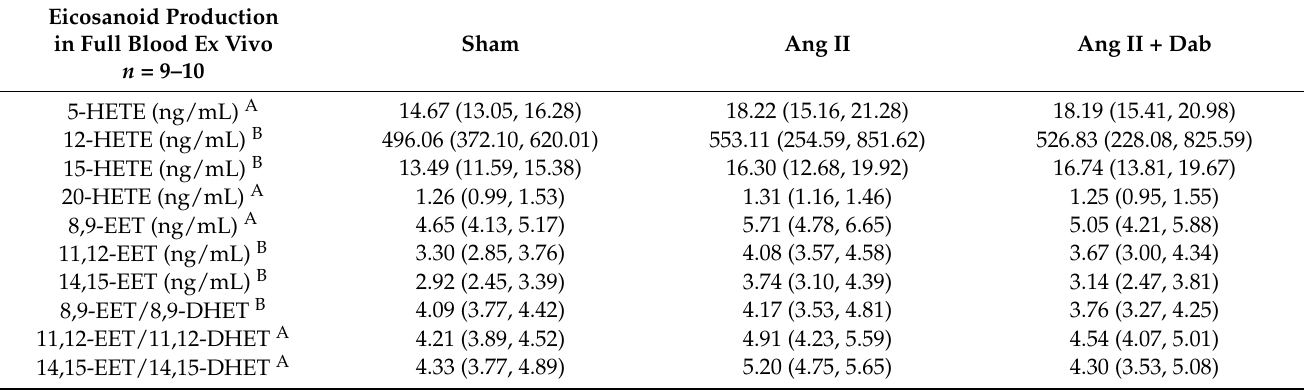
Table 1. Effect of dabigatran on eicosanoid production in full blood ex